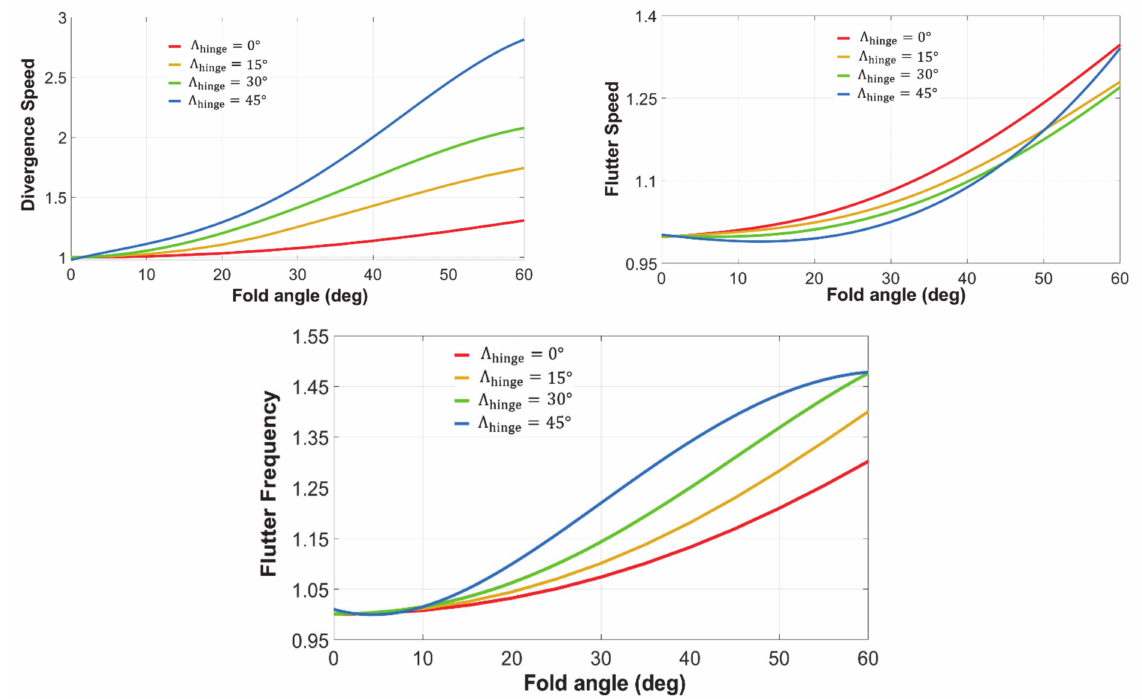
Figure 7. Variation of aeroelastic parameters for an outboard segment length of 2.032 m. On the other hand, for an outboard segment length of 1.016 m, the flutter speed increases with the fold angle for all flare angles except 0 ◦ , where increasing the fold angle reduces the flutter speed. For a 2.032 m outboard segment length, the flutter speed increases with the fold angle for all flare angles. Furthermore, at 45 ◦ flare angle, the flutter speed increases at a faster rate as the fold angle